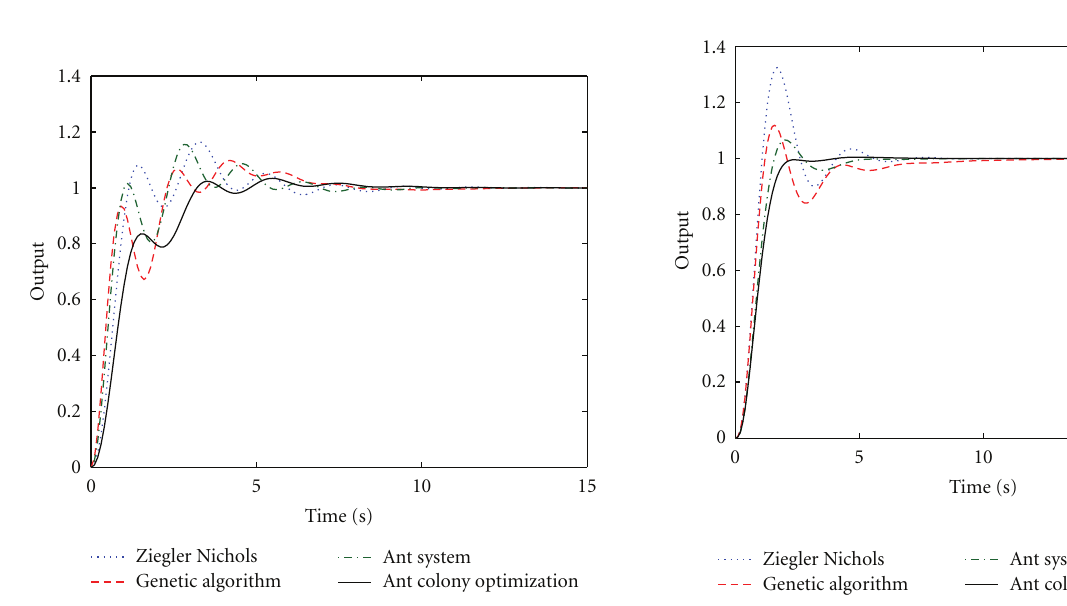
Figure 5: Convergence graph in the ACO method of the G 1 ( s ) plant.